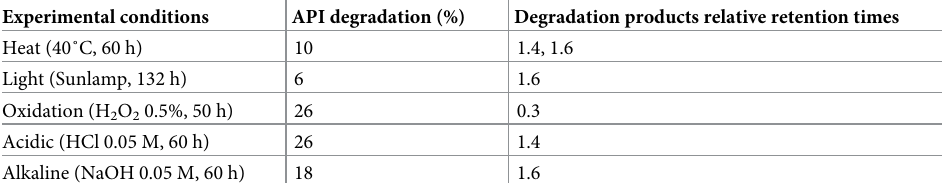
Table 3. Erythromycin forced degradation study.